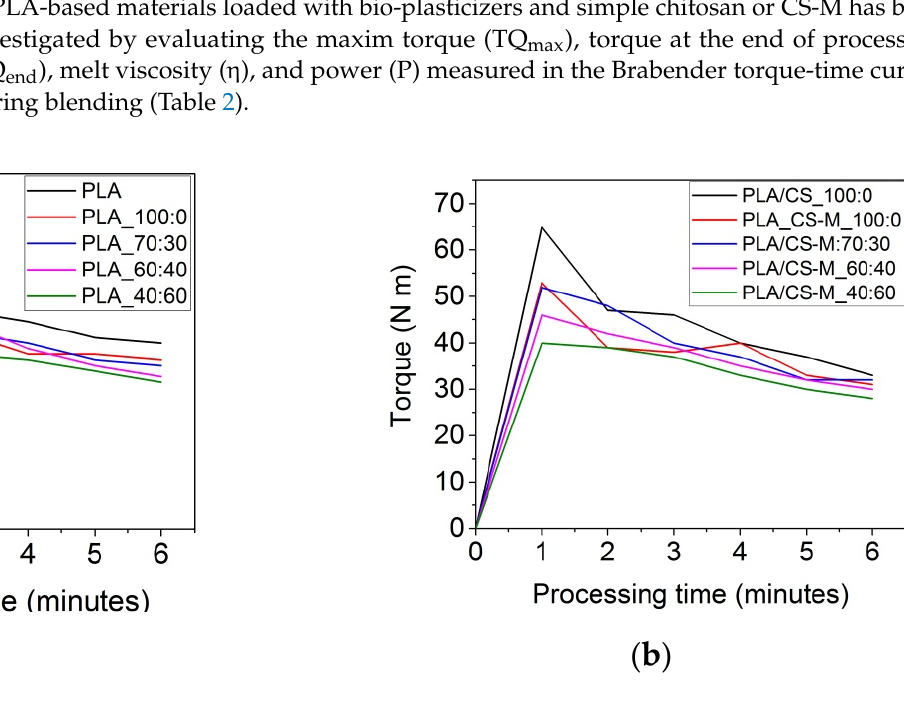
Figure 2. Torque-time curves for PLA-based materials processed by means of Brabender plastograph at temperature of 170 ± 5 °C and 60 rpm for 6 min for PLA with MB and PEG bio-plasticizers ( a ), and PLA-based plasticized composites containing MB and PEG bio-plasticizers in different ratios, CS-M and vitamin E ( b ). Table 2. Melt processing characteristics of PLA-based materials containing MB and PEG bio- plasticizers, in different ratios, CS-M and vitamin